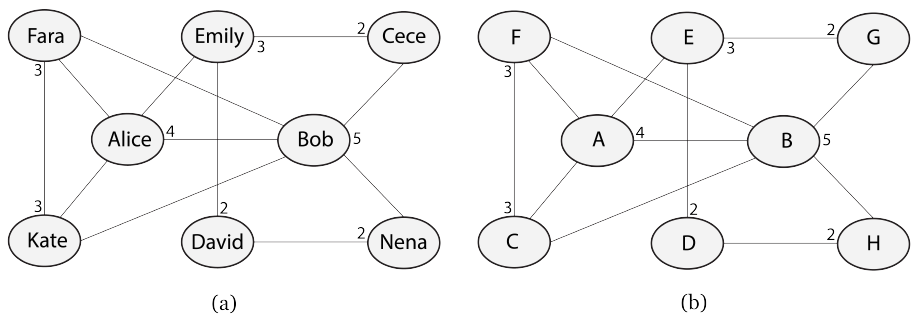
Figure 2. Social graphs: ( a ) Original graph, ( b ) naïve anonymized graph.